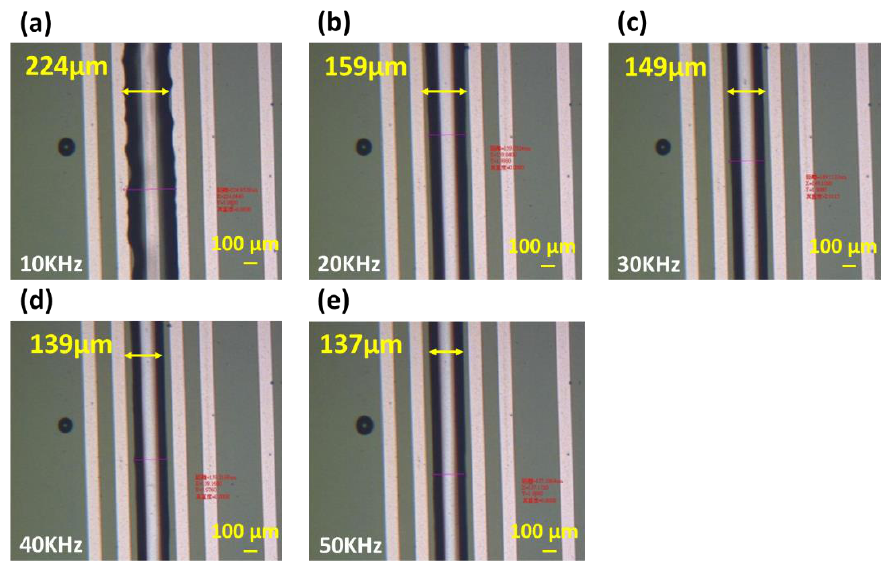
Figure 8. Linewidth of UV resin driven by dielectric force at a frequency of ( a ) 10 kHz, ( b ) 20 kHz, ( c ) 30 kHz, ( d ) 40 kHz, and ( e ) 50 kHz.